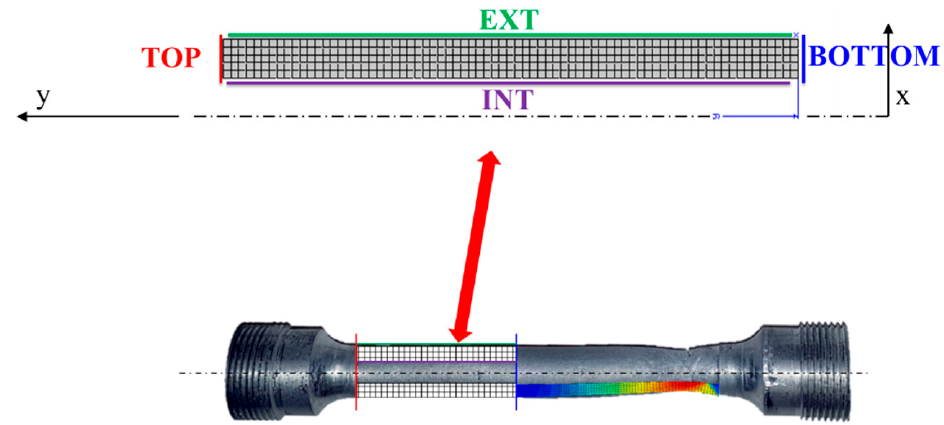
19 of 20 ( a ) ( b ) Figure A7. Evolution of thermal exchange coefficients of convective heat flow ( a ) nut and inner jaws, and ( b ) inner specimen during successive heating and cooling phases of TMF cycles. Z-set simulation The mesh used for the thermomechanical Z-set modelling of the TMF test is pre- sented in Figure A8. It is composed of 1286 square mesh nodes for 2D and axisymmetric representation of the tubular specimen as used and presented in Figure 4. The "top", "bottom", "ext" and "int" edges refer respectively to the jaw end, the middle of the speci-